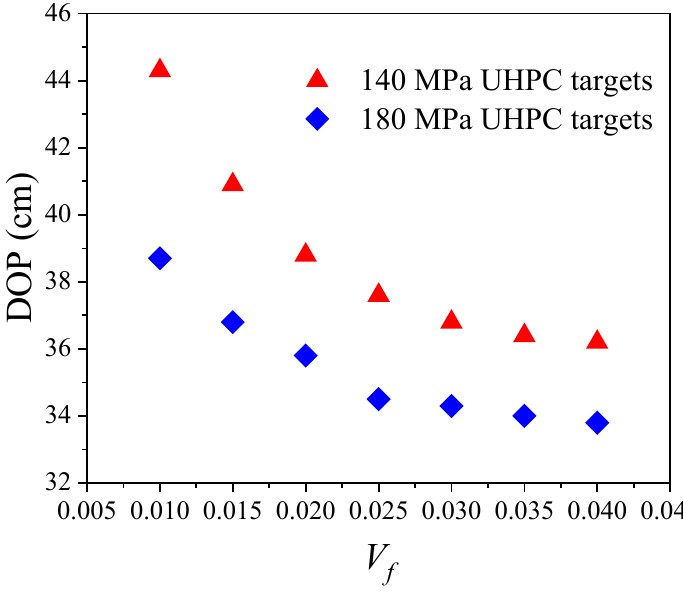
Figure 19. DOP versus volume content of the steel fiber V f for 140 MPa and 180 MPa UHPC targets, where the striking velocity is 400 m/s.